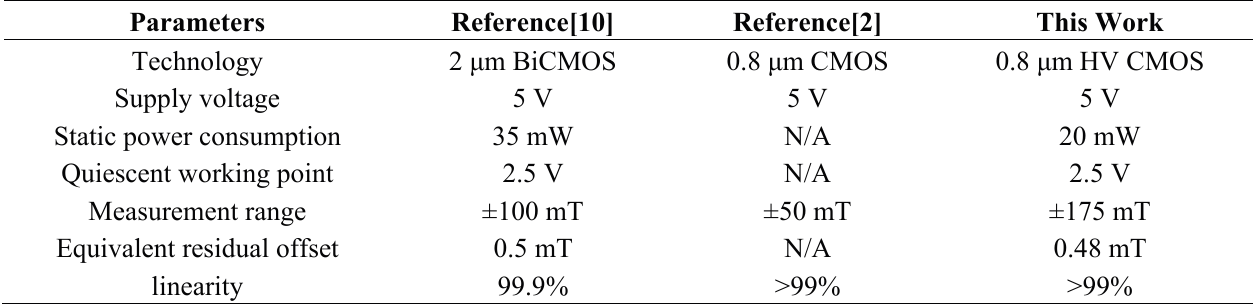
Table 1. Performance summary and comparison of CMOS monolithic integrated Hall